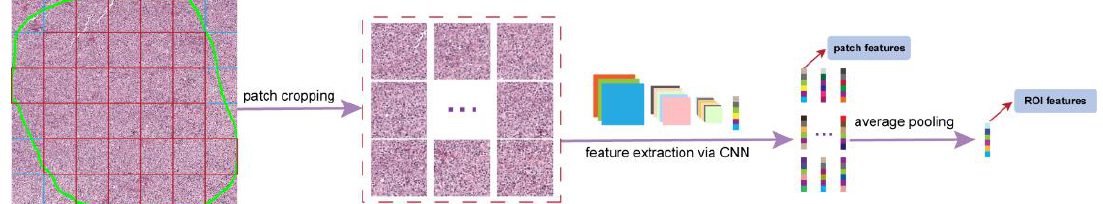
Figure 3. ROI feature extraction with the patch-based convolutional neural networks (CNN). Patches are first cropped from the ROI. The penultimate layer output from the CNN is used to represent each patch. Then average pooling is applied to the extracted patch features to generate the ROI features.